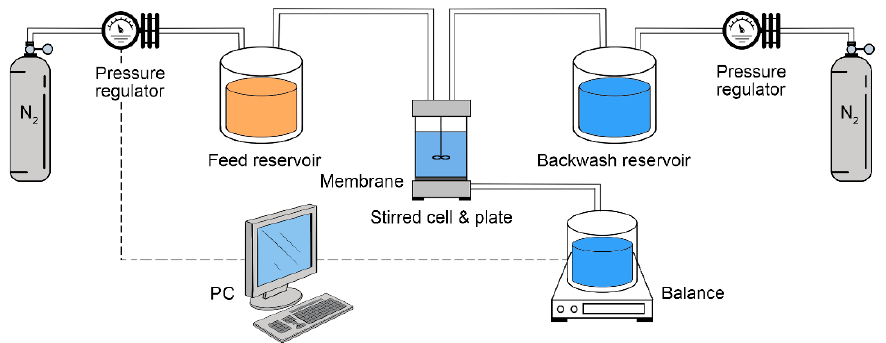
Figure 3. The dead-end filtration system, consisting of two separate paths of forward filtration and backwash.